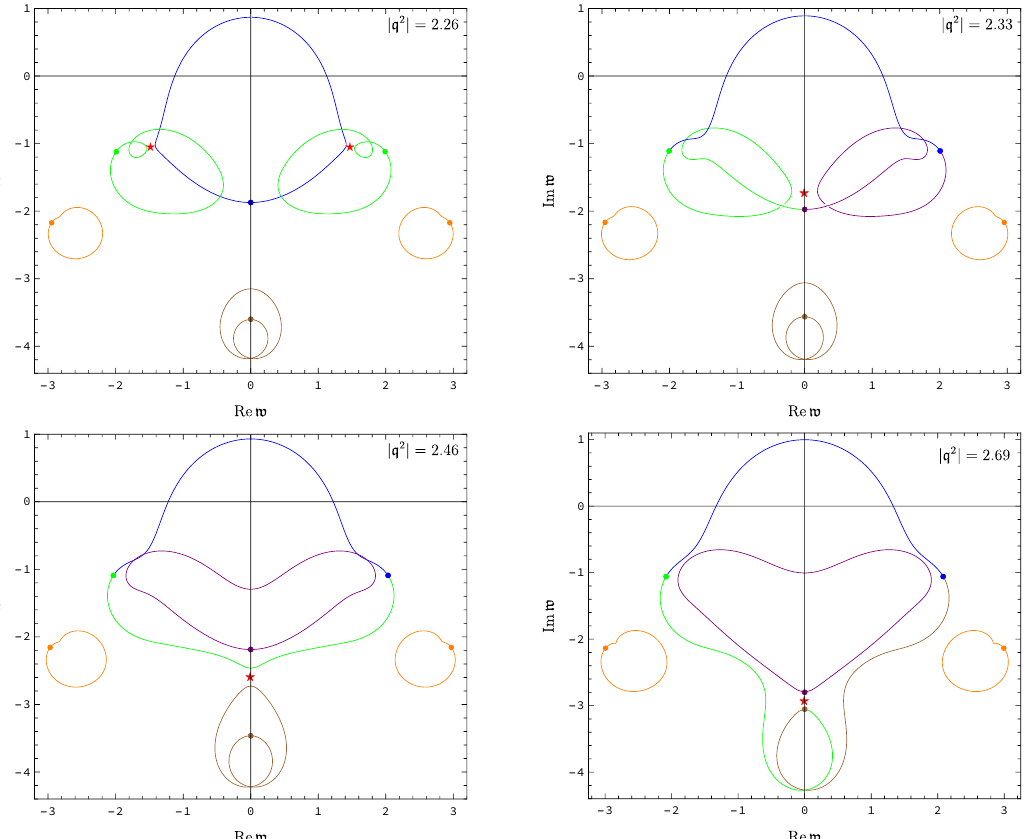
Figure 5 . Quasinormal spectrum in the shear channel at γ = 1 · 10 − 5 , computed non-perturbatively in γ . The trajectories are plotted for complex values of the spatial momentum squared, q 2 = | q 2 | e iϕ , where phase ϕ is varied from 0 to 2 π . The positions of quasinormal modes at ϕ = 0 are shown by dots. The positions of the two critical points (closest to the origin in the complex q 2 -plane) are shown by red stars. The first pair of critical points corresponds to the collision of trajectories of the two top gapped modes (shown in green) with the hydrodynamic shear mode trajectory (shown in blue) at q 2 ≈ 1 . 93027 ± 1 . 19123 i and w c ≈ ± 1 . 47755 − 1 . 05400 i . The corresponding value | q 2 | ≈ 2 . 27 c sets the radius of convergence of the hydrodynamic mode (top left panel). The second critical point arises from the collision on the imaginary axis between the parts of the common curve involving the three top modes including the shear mode (top right panel). The two plots in the bottom row show the third and the fourth critical points. Both points arise on the imaginary axis of complex frequency from the collision involving the new, non-perturbative mode in the quasinormal spectrum.